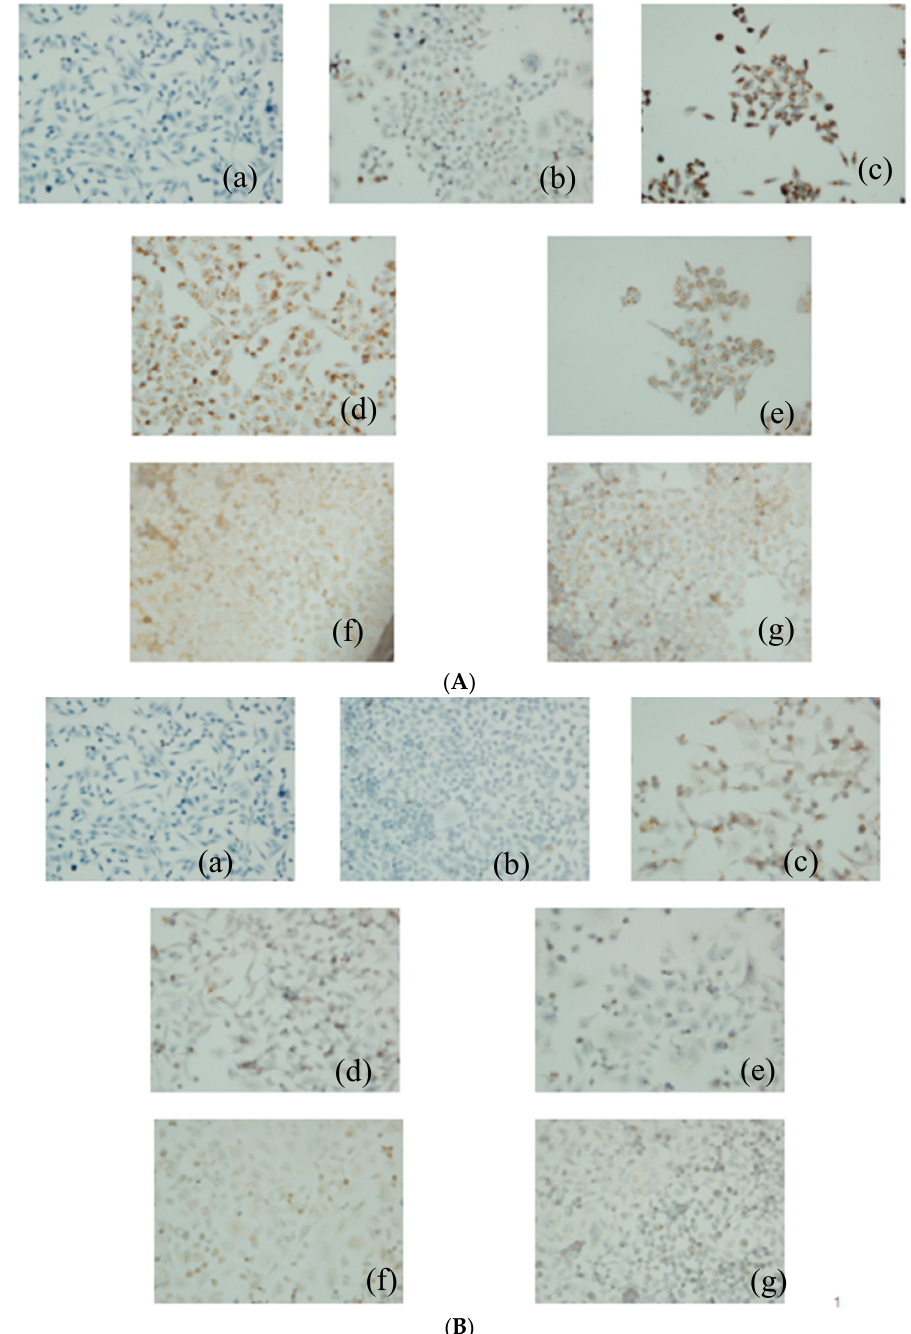
Figure 6 . Cont . Figure 6. Cont